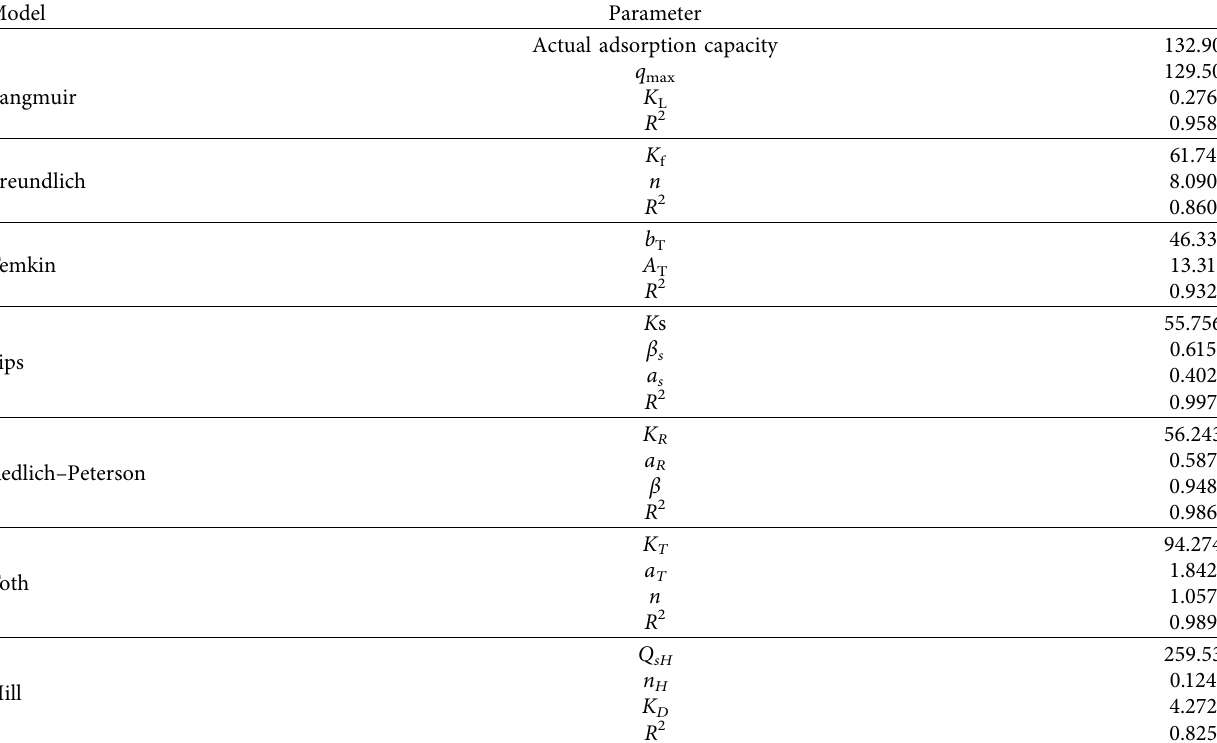
Table 3: Fitting parameters of the adsorption isotherm.